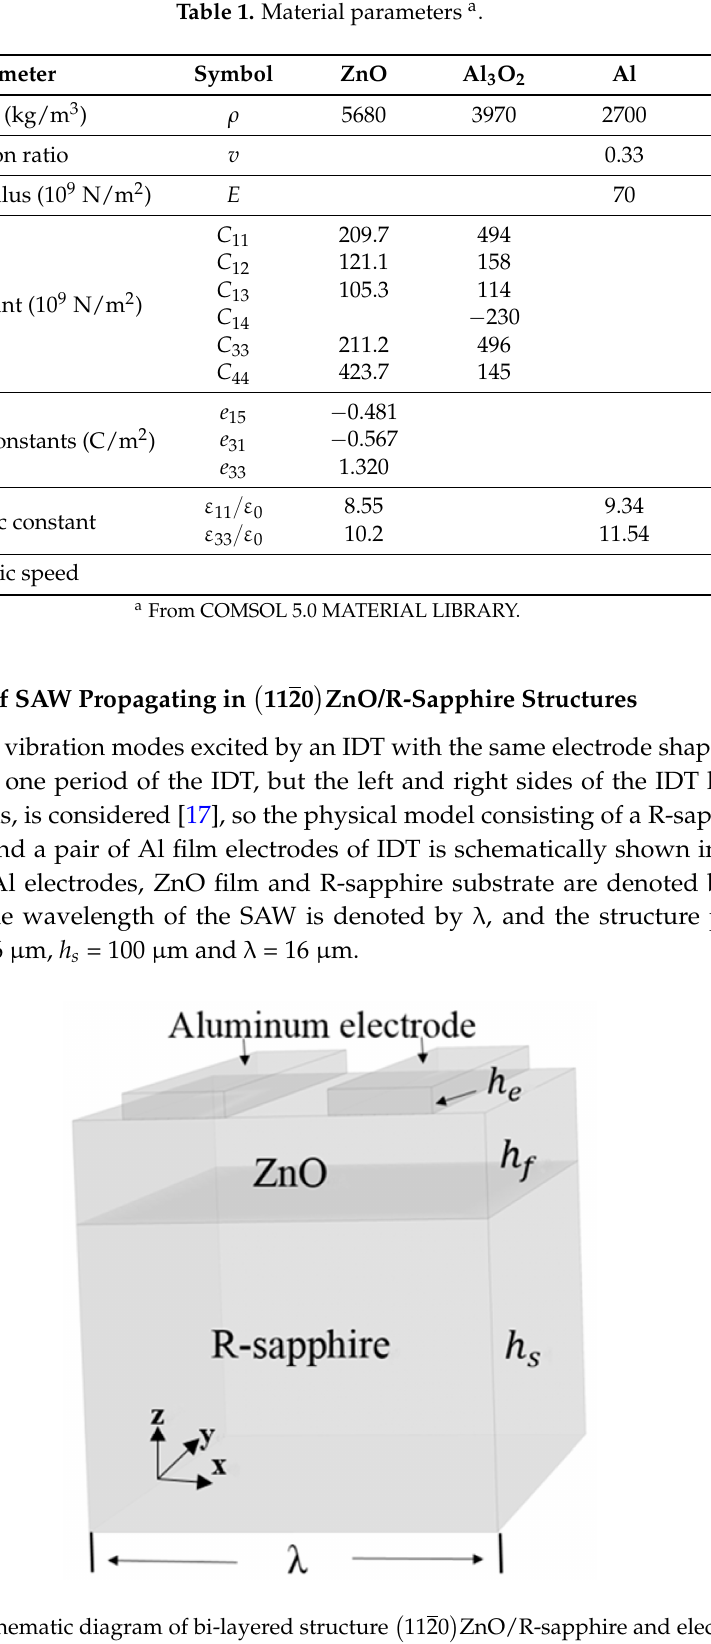
Figure 2. Schematic diagram of bi-layered structure (112(cid:3364)0) ZnO/R-sapphire and electrodes.